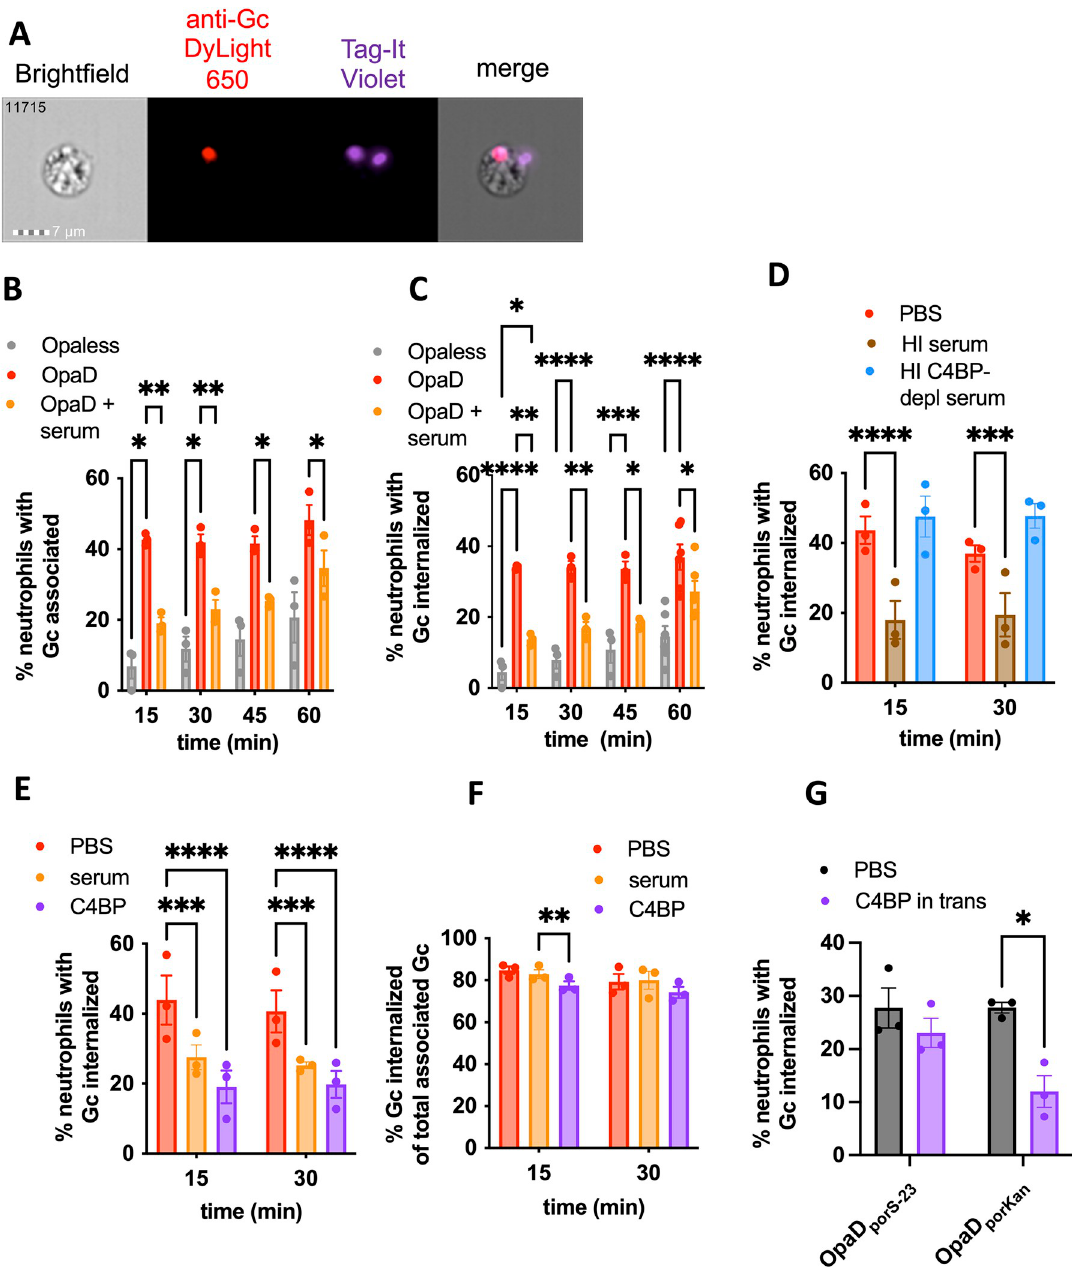
Fig 5. C4BP is necessary and sufficient for serum-mediated decrease in neutrophil internalization of OpaD+ Gc. Gc were labeled with Tag-IT Violet (TIV), treated as indicated in the following graphs, and incubated with adherent, IL-8-treated primary human neutrophils. At the indicated times, cells were fixed and stained with DyLight 650 (DL650)-labeled anti-Gc antibody without permeabilization to recognize extracellular bacteria. Neutrophils were analyzed via imaging flow cytometry. (A) Data from 12,000 neutrophils with untreated OpaD+ Gc at 60 min were collected. One of these cells, number 11715, is displayed as a representative, with images captured from channels for (left to right) phase contrast, intracellular bacteria (red), total associated bacteria (purple), and merge. (B-C) Neutrophils were exposed to Opaless Gc (gray), OpaD+ Gc (red), or OpaD+ Gc incubated in C4BP-replete serum (25%, orange; Lund University). (B) reports the percentage of single, focused, intact neutrophils with � 1 cell-associated bacterium (TIV + ); (C) reports the percentage of neutrophils with � 1 phagocytosed bacterium (TIV + DL650 − ). (D) Neutrophils were exposed to OpaD+ Gc in PBS (red), or heat-inactivated serum that was intact (brown; Lund University) or C4BP-depleted (blue, both at 25% final), and the percentage of phagocytosed bacteria was calculated as in (C). (E-F) Neutrophils were exposed to OpaD+ Gc in PBS (red), serum (25%, orange; Lund University), or purified C4BP (50 μ g/ml, purple). In (E), the percentage of phagocytosed bacteria was calculated as in (C). In (F), the percentage of cell-associated Gc that are internalized was calculated. Results are the mean ± SEM from � 3